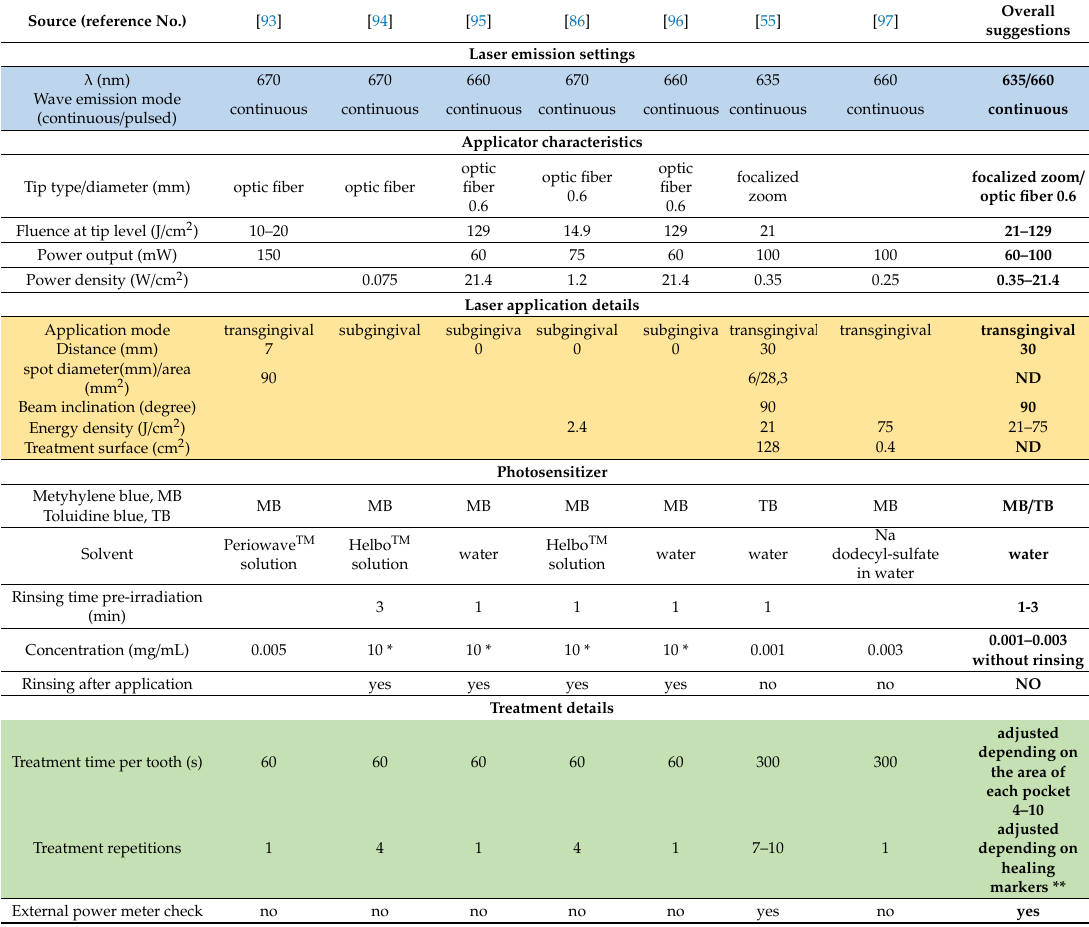
Table 4. Suggested parameters for photodynamic therapy